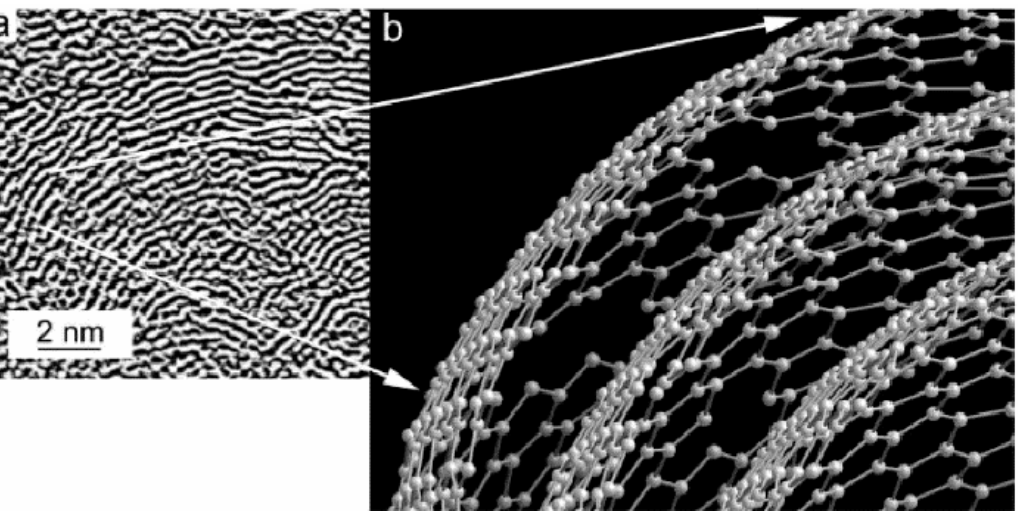
Figure 11. ( a ) An example of soot nanostructure with contrast of carbon layers enhanced digitally. ( b ) A schematic model for three graphene-like layers in soot nanostructure. Reproduced with permission from Buseck et al. [55]. Copyright Taylor & Francis, 2014.